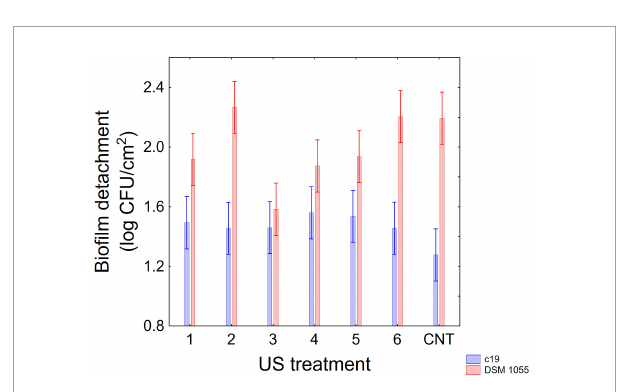
FIGURE5 Decomposition of statistical hypothesis related to the interactive term “strain × US treatment” on the detachment of biofilm (log CFU/cm 2 ) of L. plantarum c19 and DSM 1055. Mean values ± 95% confidence